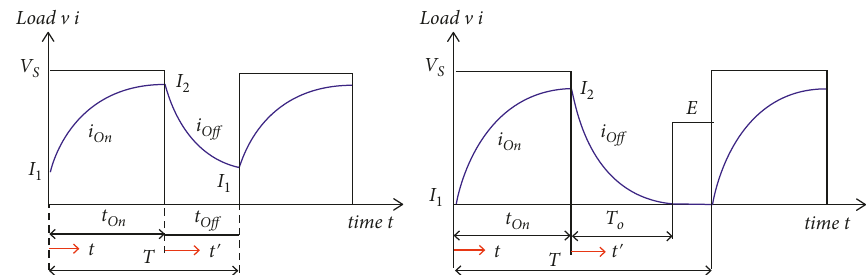
Figure 7: Continuous and discontinuous load current modes.